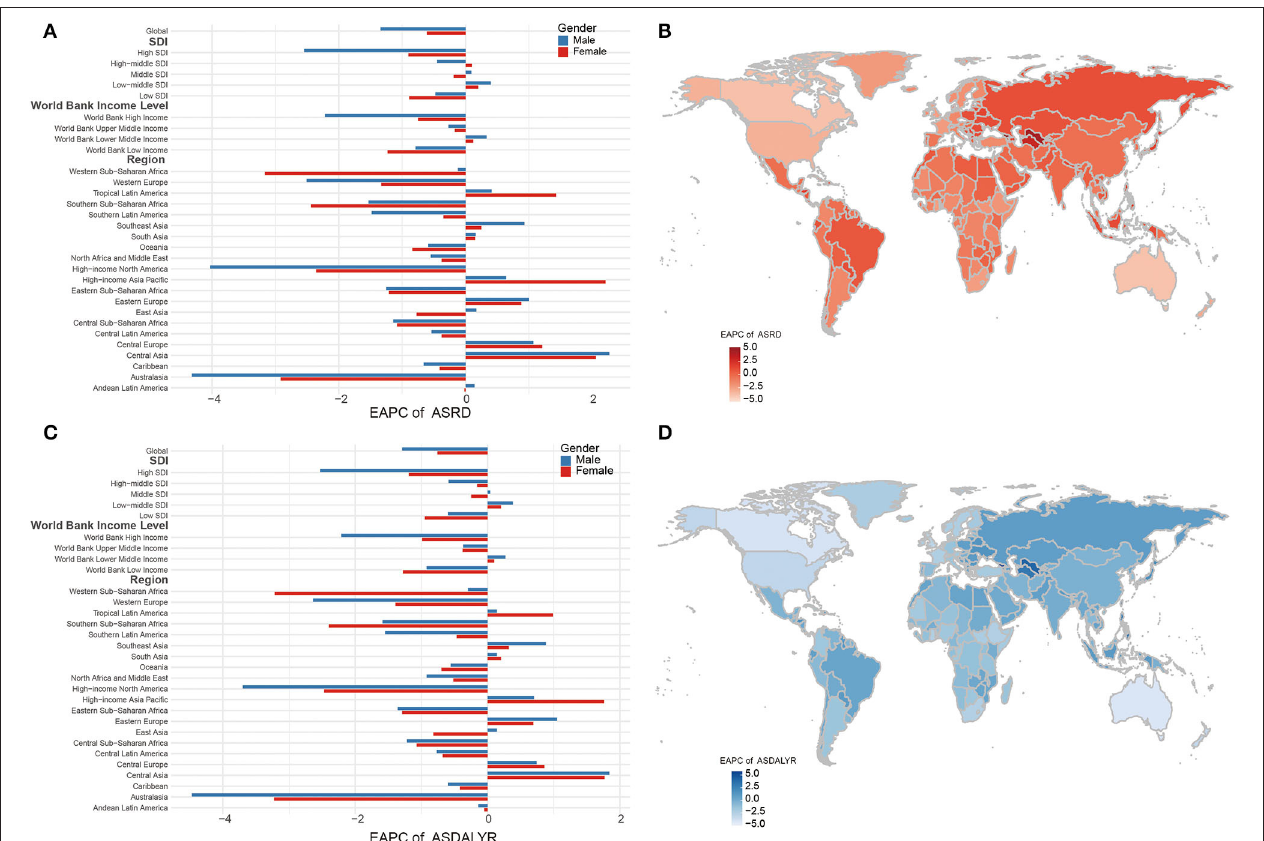
FIGURE 3 | EAPC in ASRD and ASDALYR. (A) Global EAPC of ASRD with 31 regions. (B) EAPC of ASRD in 204 countries and territories in 2019. (C) Global EAPC of ASDALYR in 30 regions. (D) EAPC of ASDALYR in 204 countries and territories in 2019. EAPC, estimated annual percentage change; ASRD, age-standardized death rate; ASDALYR, age-standardized DALY